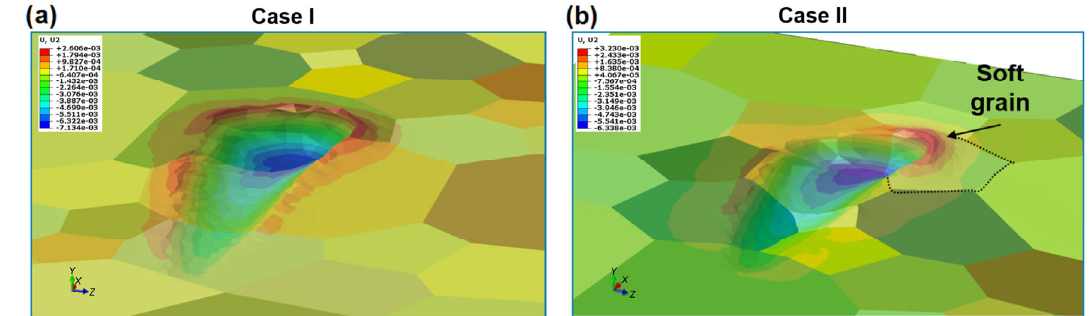
Fig. 6 Surface deformation for (a) case I and (b) case II. Deformation is up-scaled by a factor of 5 for